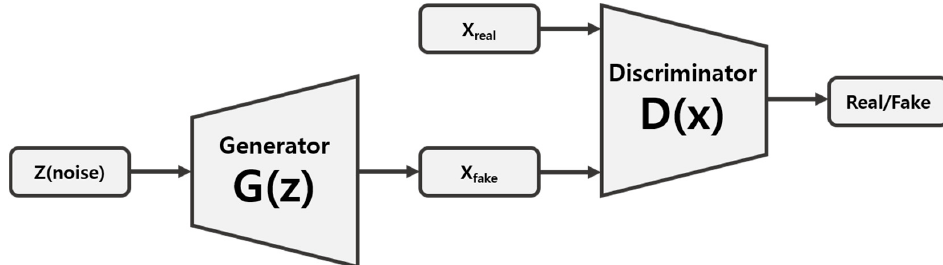
Figure 3. Overview of GAN